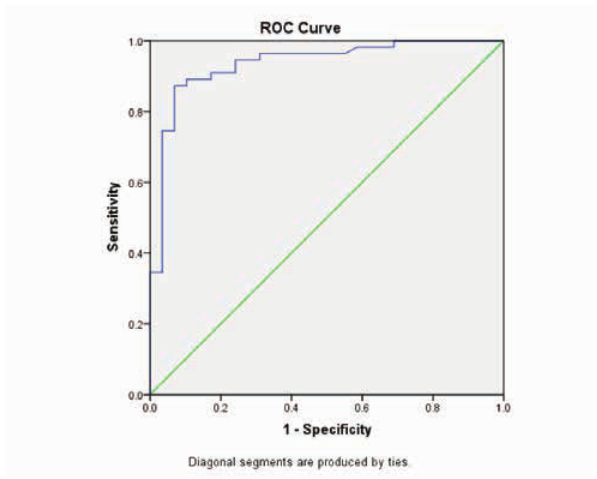
Figure 3: Receiver operating characteristic (ROC) curves evaluating the accuracy of using lesion size in LPI